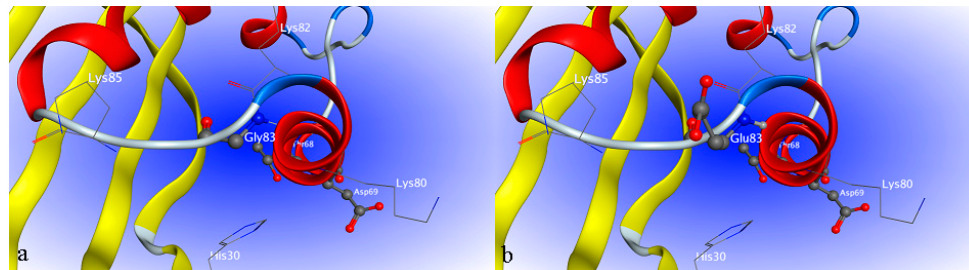
Figure 5. Part of the tertiary structure of H 1-2 P 3 H 4 P 5-6 H 7-8 before and after amino acid replacement at position 83, constructed using MOE. Amino acid residue 83 is shown as a ball and stick structure. The α -helix is shown in red; the β -sheet is shown in yellow. ( a ) 3D structure with amino acid residue G83; ( b ) 3D structure with amino acid residue E83.